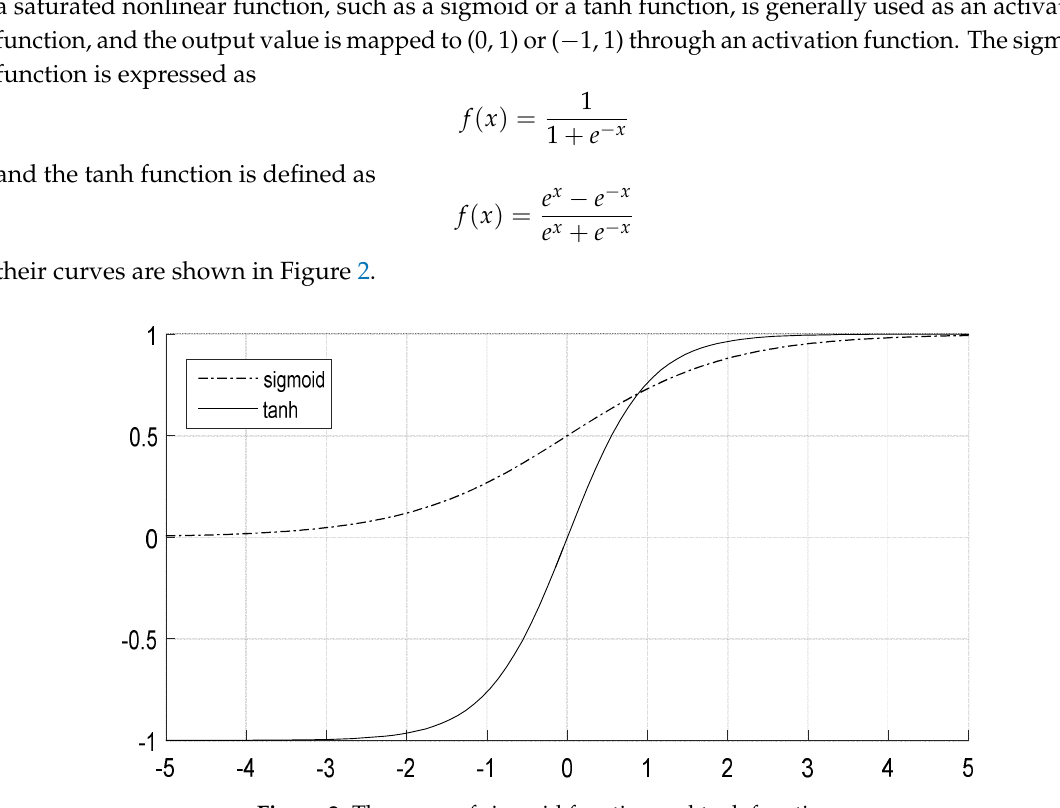
Figure 2. The curve of sigmoid function and tanh function.